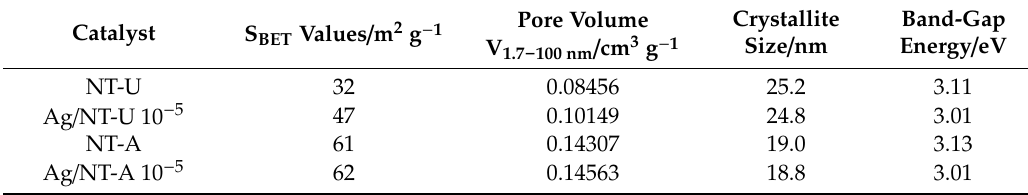
Table 1. Characteristic values of the catalysts prepared.